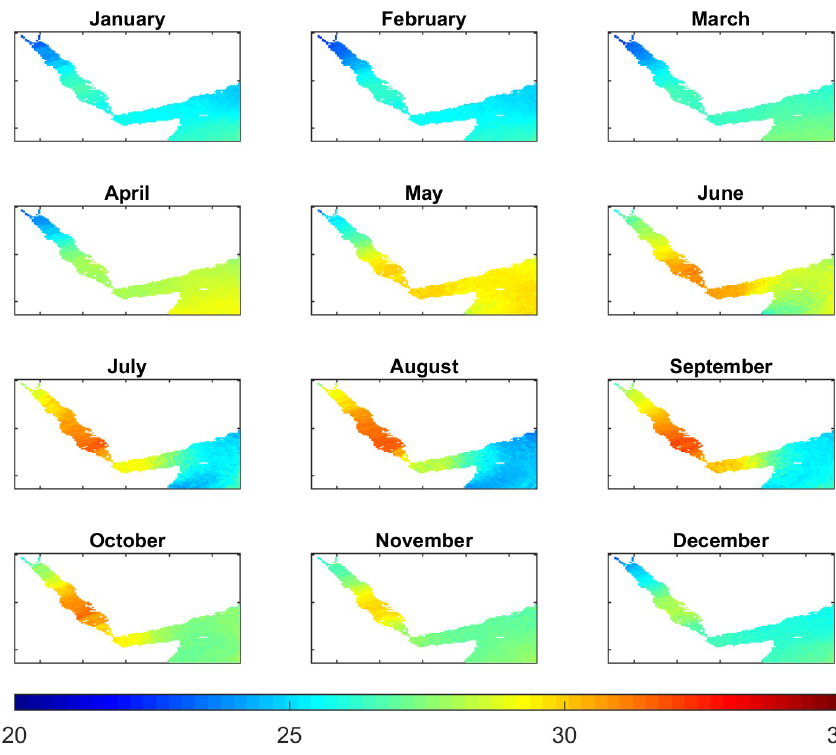
Figure 12. Monthly climatology of the surface temperatures (in ◦ C).